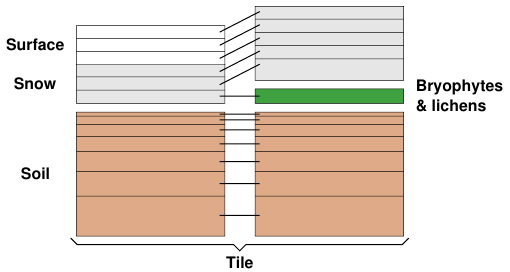
Figure 3. Averaging scheme for the vertical temperature profile of a tile: the left column corresponds to the part of the tile where no bryophyte and lichen layer is present, the right column corresponds to the part covered by bryophytes and lichens. The columns consist of seven soil layers (brown), an optional bryophyte and lichen layer (green), up to five snow layers (grey) and several optional empty layers (white). The black horizontal bars connect layers which are averaged with regard to their temperature. The surface fractions of the two parts are used as weights for the averaging. The empty lay- ers are assumed to have surface